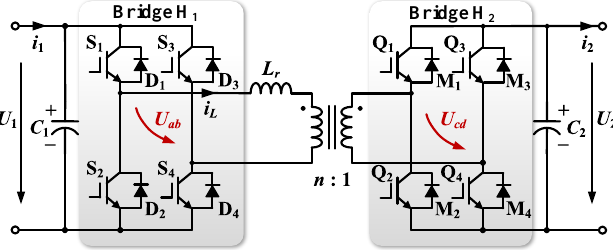
Figure 1. Topology of dual active bridge (DAB)